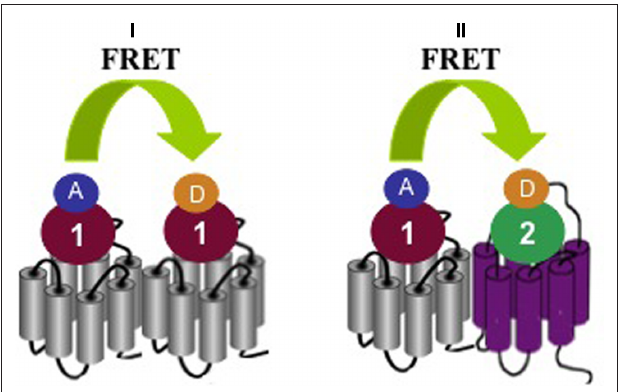
FiGuRE 2 | Detection of homo/heteromer formation by FRET using fluorescent ligands. (i) In the case of homomer formation a FRET signal can be detected between a selective donor (D) ligand I that binds the first protomer and a selective acceptor (A) ligand 1 that binds the second protomer The donor and acceptor ligands can be the same molecule but labeled differently. (ii) In the case of heteromer formation, a FRET signal can be detected between a selective donor ligand 1 that binds the first protomer and a selective acceptor ligand 2 that binds the second protomer. In this case, donor and acceptor ligands are different molecules.